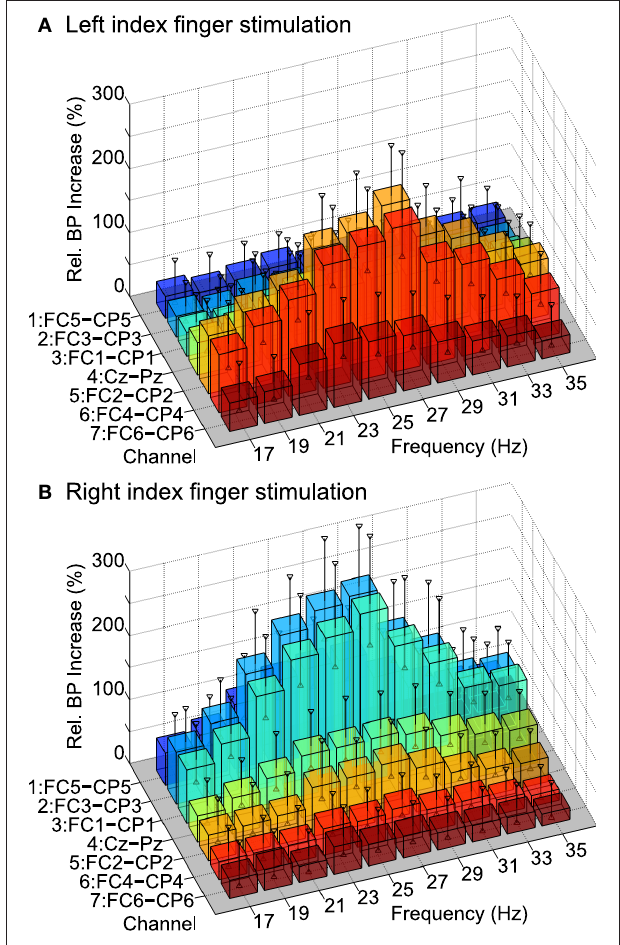
FIGURE 6 | Grand average tuning curve maps over all subjects. The relative bandpower increase is shown at 10 stimulation frequencies and seven bipolar channels above the somatosensory cortex for (A) left and (B) right index finger stimulation. Vertical markers indicate grand average confidence intervals ( α = 95%) estimated with